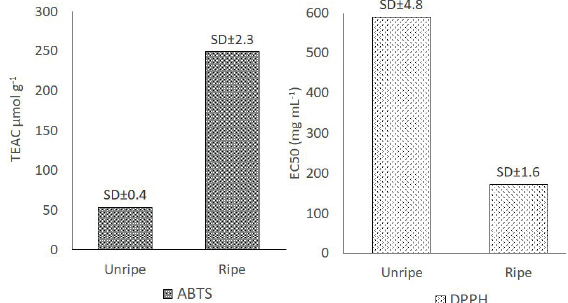
Figure 2 - Antioxidant capacity of the ackee arilli ( Blighia sapida ) fruit in two maturation stages. ABTS expressed in TEAC (Trolox equivalent antioxidant capacity) as µmol of Trolox equivalents per gram of fresh sample. DPPH expressed in EC50 (concentration of ackee extract required to reduce the absorbance of the radical by 50%) in